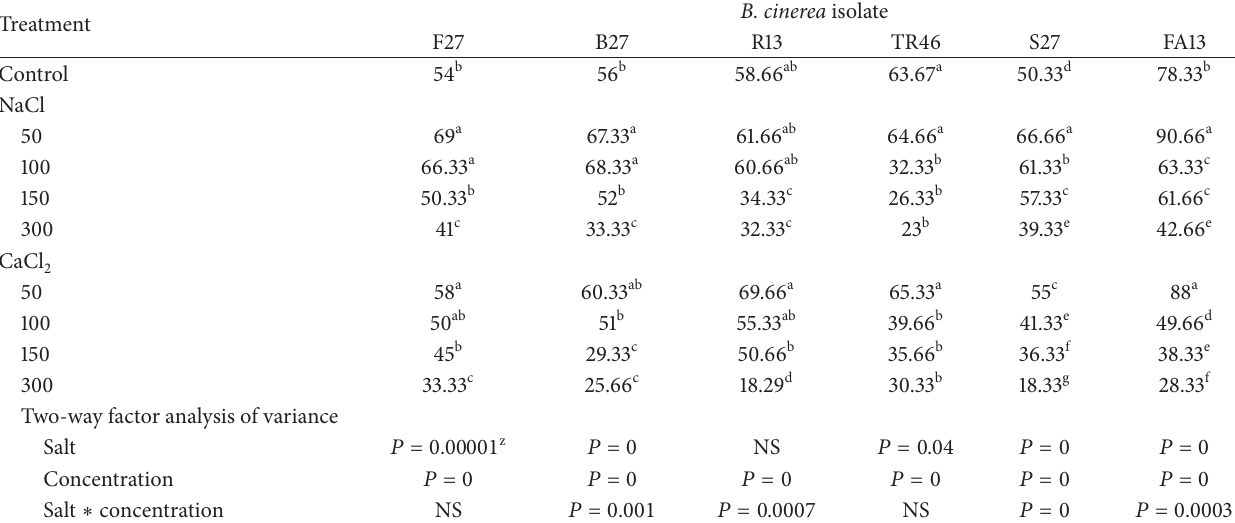
Table 3: The effect of sodium and chloride salts on the germination of Six Isolates of Botrytis cinerea (percent germination was measured ater 24 h incubation at 25 ∘